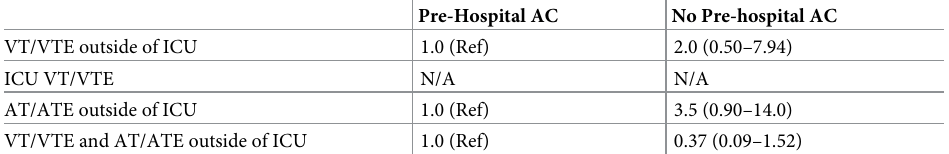
Table 4. Risk ratios (95% CI) of clotting events in COVID-19 patients based on the use of anti-coagulation prior to